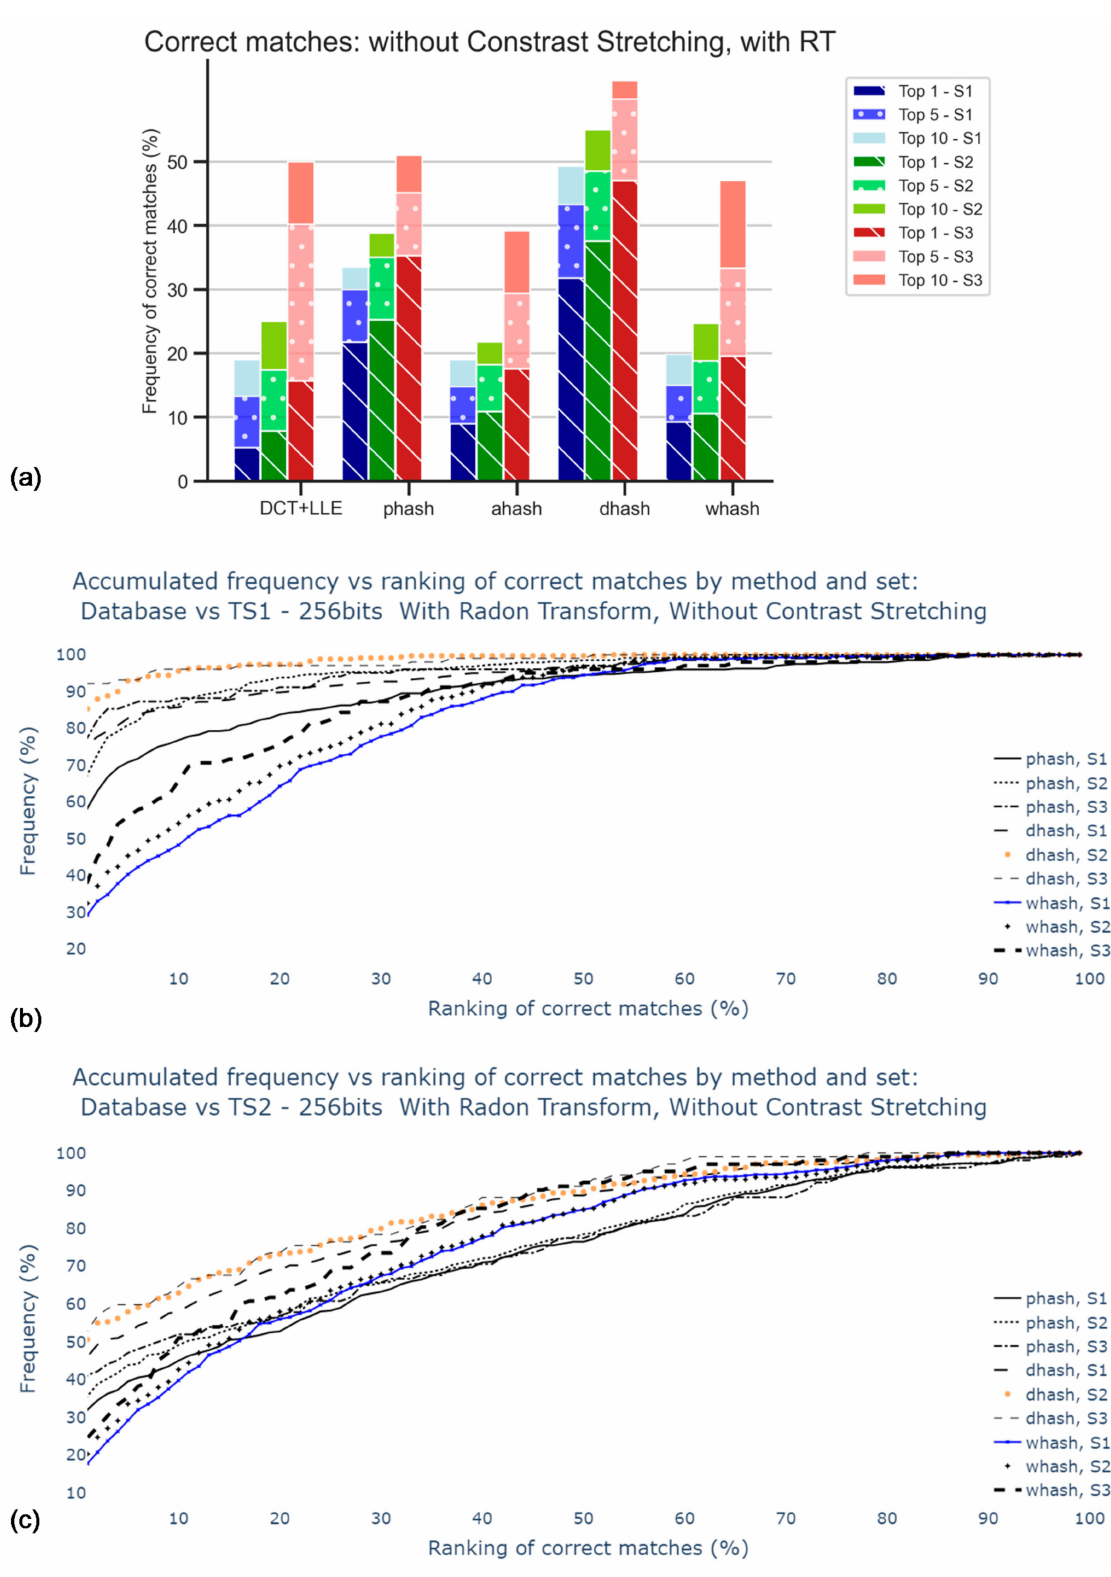
Figure 10. Percentage of correct matches without application of contrast stretching: ( a ) for the worst cases between TS1 and TS2 comparisons and only for top 1, top 5, and top 10; ( b ) for the comparison with TS1, all rankings (in percentage); ( c ) for the comparison with TS2, all rankings (in